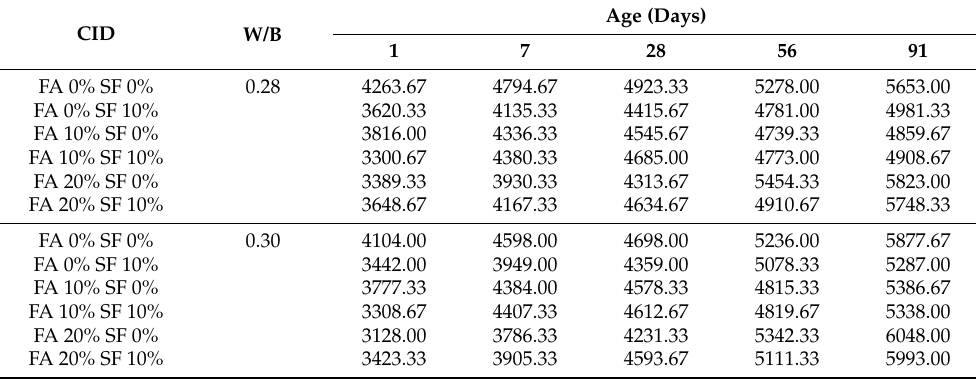
Table A2. Source data for tests on ultrasound wave velocity (unit: m/s).